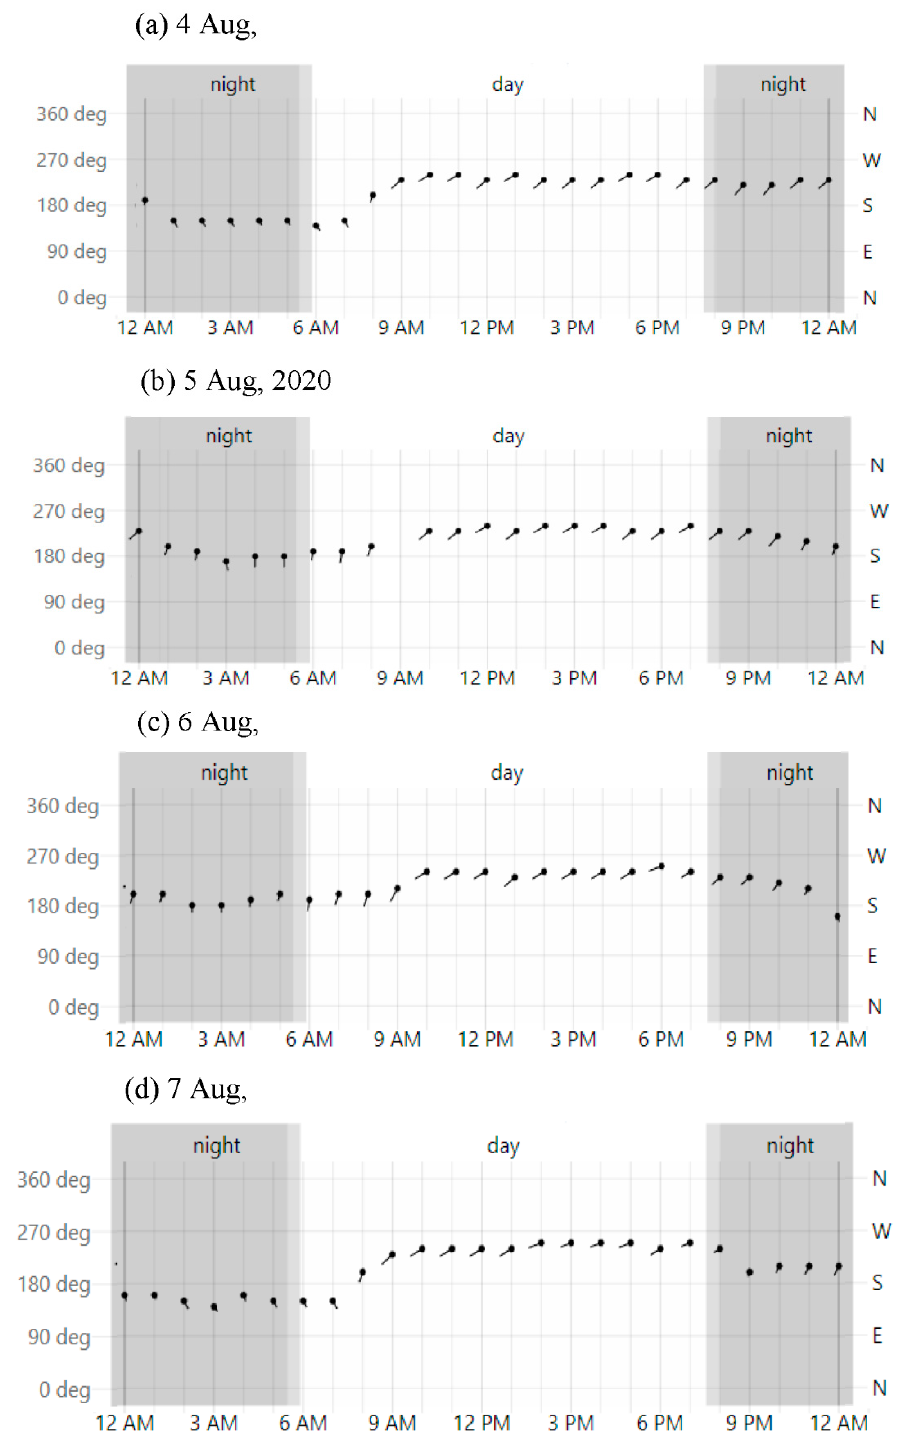
Figure 10. Wind direction on ( a ) 4 ( b ) 5 ( c ) 6, and ( d ) 7 August 2020. Measured wind direction is measured at about 10 m above sea level. Civil twilight and night are indicated by shaded overlays. [48].